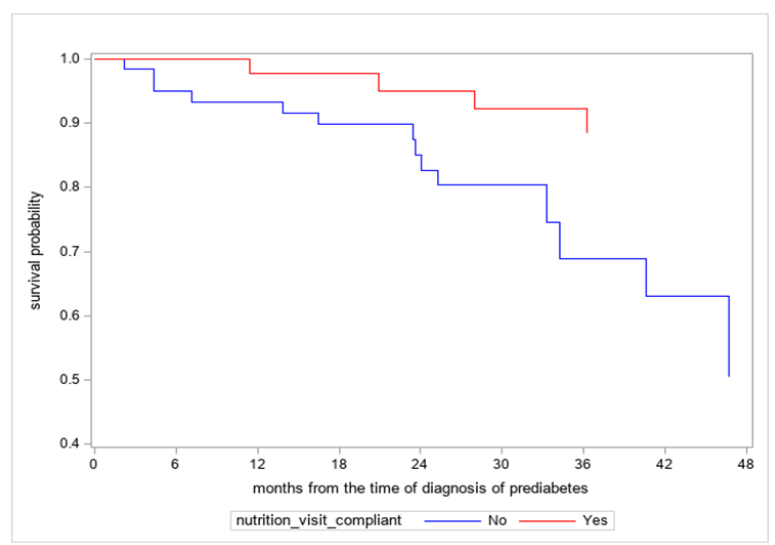
Figure 1. Kaplan – Meier survival analysis of the progression from prediabetes to type 2 diabetes (T2D). The hazard ratio of progression from prediabetes to T2D for the non-adherent subjects compared to the adherent subjects was 3.88 (95% CL 1.26–11.98, p = 0.02) [43].